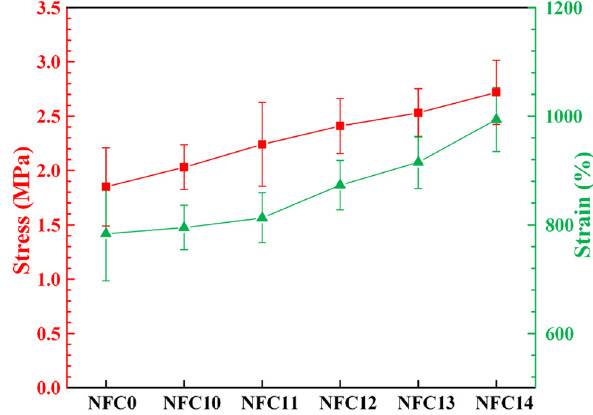
Figure 3: Stress – strain pro fi les of intelligent PDMAA hydrogels with various NFC